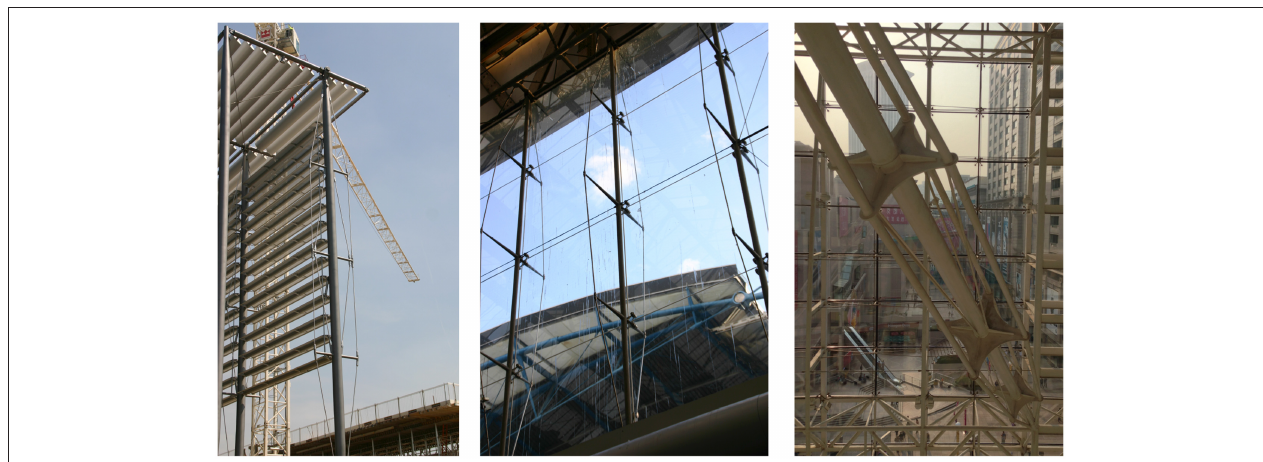
FIGURE 15 | Prestressed stayed columns in practice. (Left to right) An example as a slender support for a façade in Chiswick Park, West London; a set of roof supports in the former Eurostar terminal in Waterloo Station in Central London; an example in a shopping mall in Dalian, China. Photographs courtesy of Dr. Daisuke Saito and Dr. Jialiang